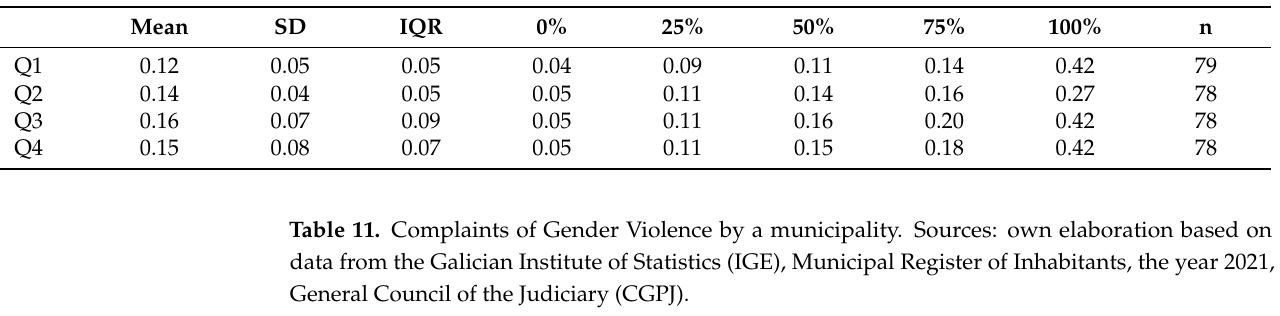
Table 10. Social protection actions per inhabitant. Sources: own elaboration based on data from the Galician Institute of Statistics (IGE), Municipal Register of Inhabitants, the year 2021, General Council of the Judiciary (CGPJ).